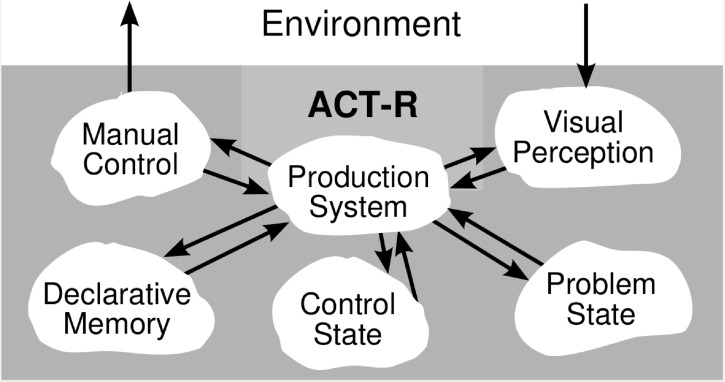
Connection of modules in ACT-R 5.0 [18].